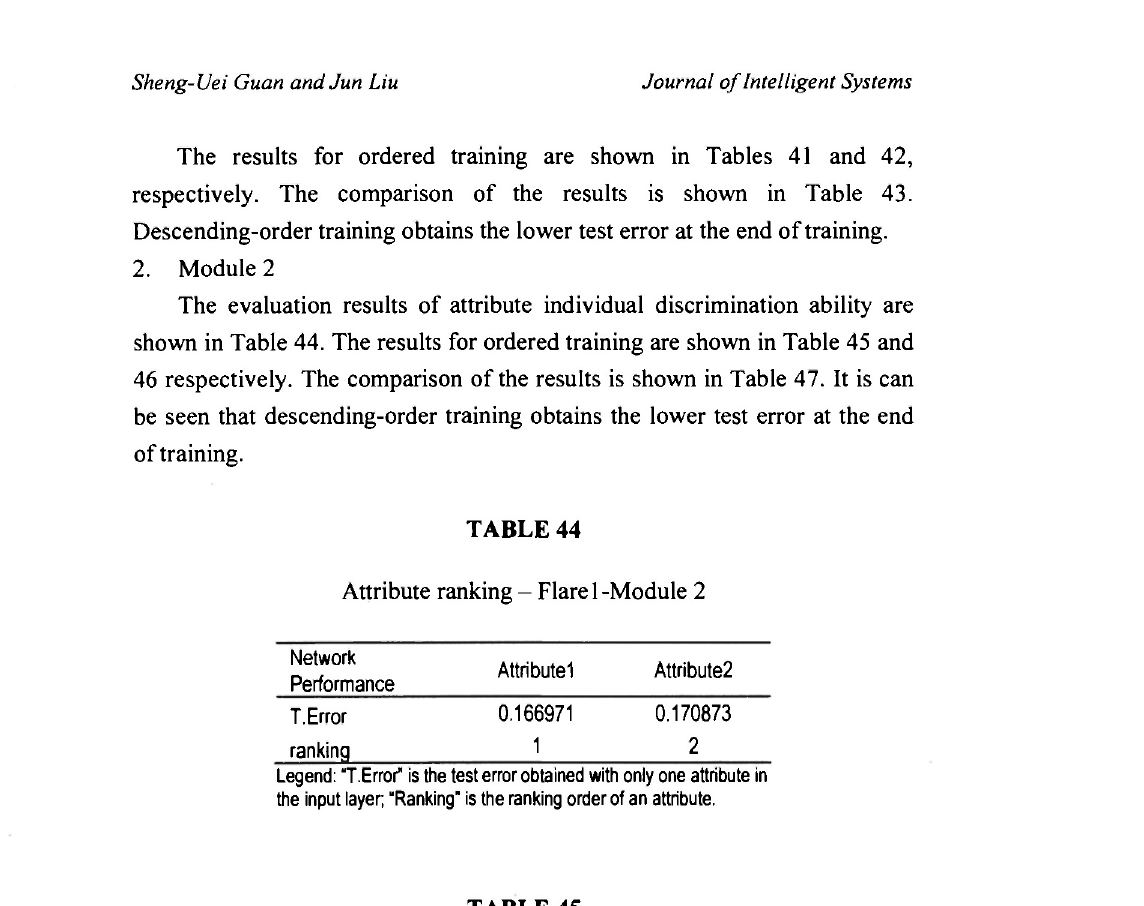
Ascending-order training - Flare 1 -Module